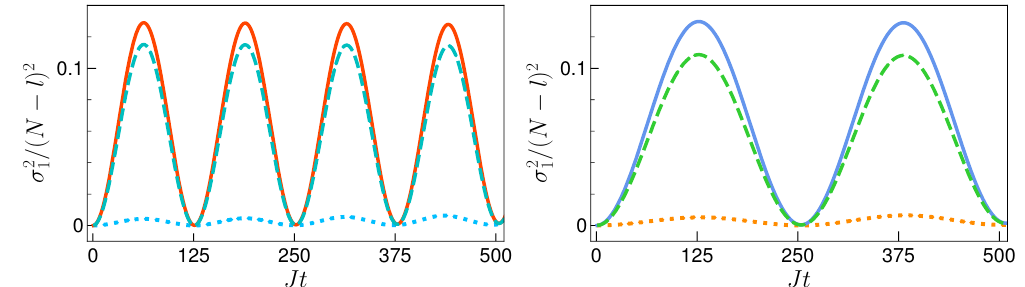
Figure 6: Time evolution of quantum fluctuations. Dimensionless units are used, and the fluctuations are normalised by ( N − l ) 2 . We set J = 1 and N = 60. The left panel is for U = 0.17, l = 0 and initial states: | 60,0,0 〉 (dot blue line), | 40,0,20 〉 (dashed cyan line) and | 30,0,30 〉 (solid red line). The right panel is for U = 0.7, l = 9 and initial states: | 51,9,0 〉 (dotted orange line), | 36,9,15 〉 (dashed green line) and | 26,9,25 〉 (solid blue